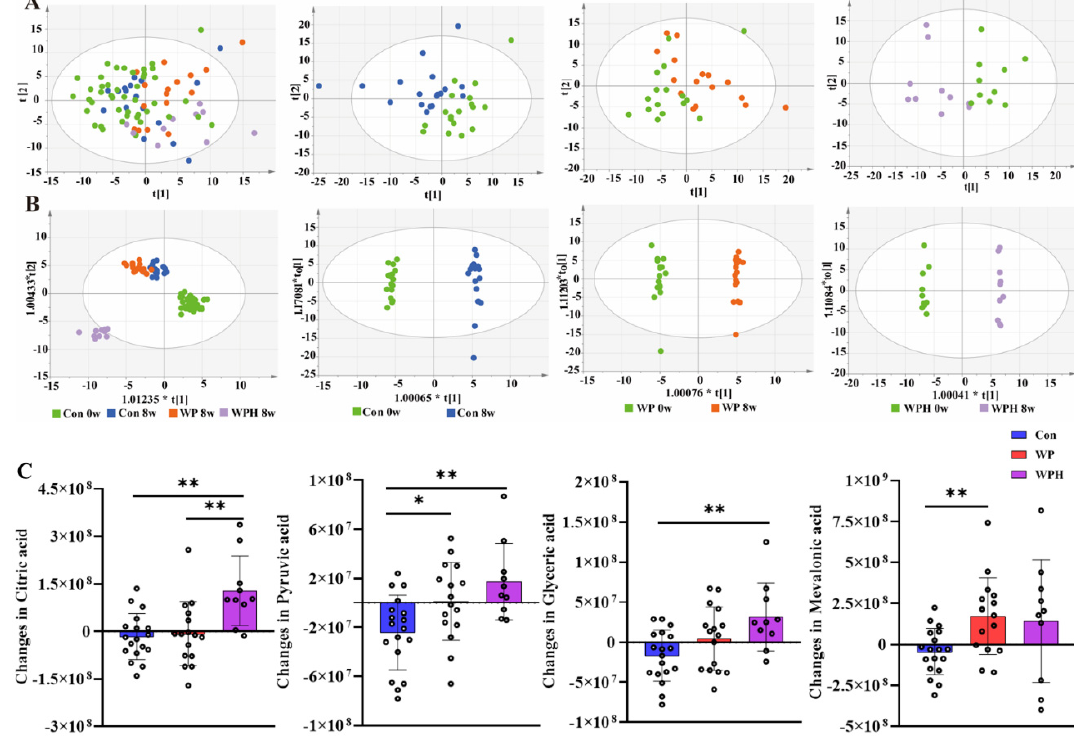
the genus levels when compared among the three groups. At the phylum level, Bac- eride; * p < 0.05, ** p < 0.01, compared with baseline; & p < 0.05, compared with the changes of WP teroidetes and Firmicutes were dominant in human intestinal bacteria. In the control group. group, Bacteroidetes were significantly decreased and Firmicutes were significantly in- creased compared with baseline. No significant differences were observed in the ratio Nine serum metabolites significantly changed in concentration after the intervention, of Bacteroidetes and Firmicutes (B/F) between baseline and end of intervention among and four metabolite changes had significant differences compared between groups ( p < the three groups (Figure 4A). At the family level, the percentage of Bifidobacteriaceae, 0.05, FDR < 0.05) (Table S2). Among the four metabolites, mevalonic acid was significantly Lachnospiraceae, Streptococcaceae, and Veillonellaceae was significantly increased com- upregulated in the WP group compared with the control group. Citric acid, pyruvic acid, pared with the baseline in the control group. WP intervention significantly increased the and glyceric acid were significantly upregulated in the WPH group compared with the percentage of Lachnospiraceae and Clostridiaceae (Figure 4B). At the genus level, the control group. Citric acid was significantly upregulated in the WPH group compared with percentage of Bifidobacterium, Lachnospira, and Streptococcus was significantly increased the WP group (Figure 2). The coordinated effects of change in metabolites might be en- compared with baseline in the control group. WP intervention significantly increased riched for pathways, and further analysis indicated that the TCA cycle pathways were the percentage of Bifidobacterium and Phascolarctobacterium (Figure 4C). Bacteria with upregulated in the WPH group. significant differences among the three groups were not found via SEfSe analysis.